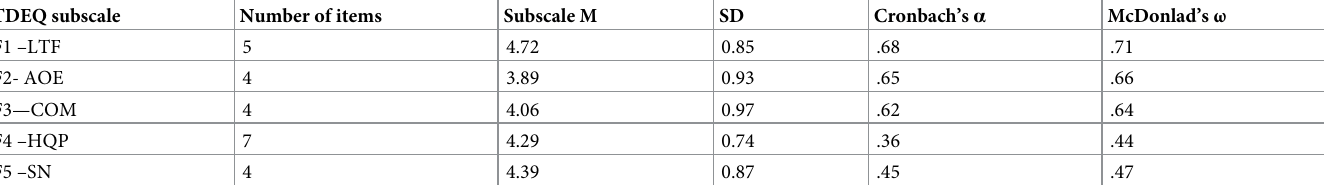
Table 3. TDEQ-FV subscale analysis ( n = 64).